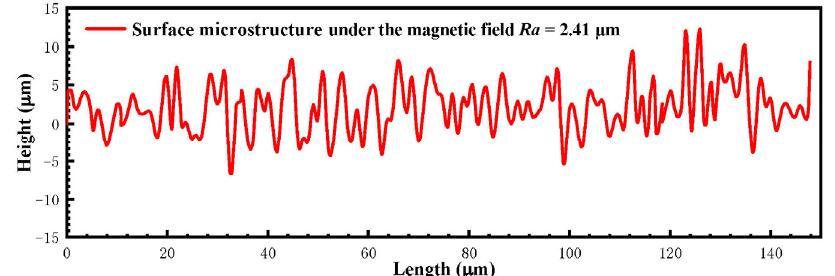
Fig. 4 The new surface micro-profile under the magnetic field is applied on.